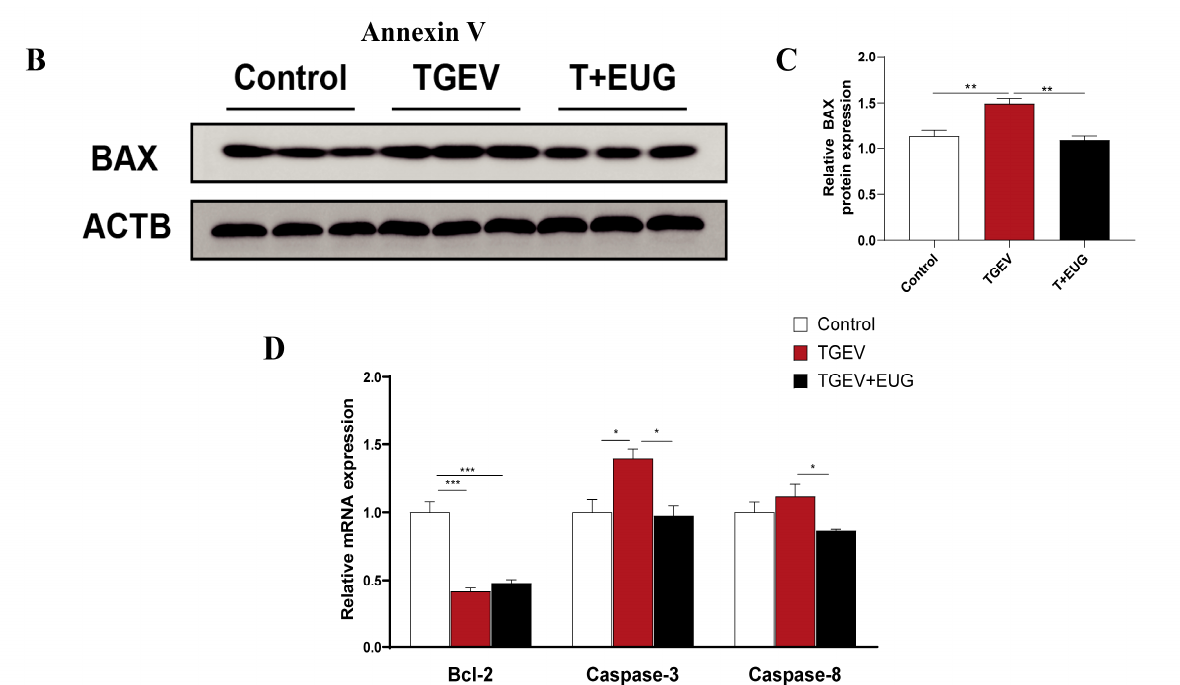
Figure 10. Effect of eugenol on TGEV-induced IPEC-J2 cells’ death pattern. IPEC-J2 cells were treated with 200 μ M eugenol for 1 h and then infected with TGEV for 36 h. ( A ) The percentage of apoptosis in jejunum epithelial cells was analyzed by flow cytometry ( n =3). ( B , C ) Immunoblot analysis and quantification of BAX in IPEC-J2 cells ( n = 3). ( D ) Relative mRNA expressions of Bcl-2, Caspase-3 and Caspase-8 in IPEC-J2 cells ( n = 3). Data are expressed as the mean ± SEM. * p < 0.05, ** p < 0.01, *** p < 0.001.